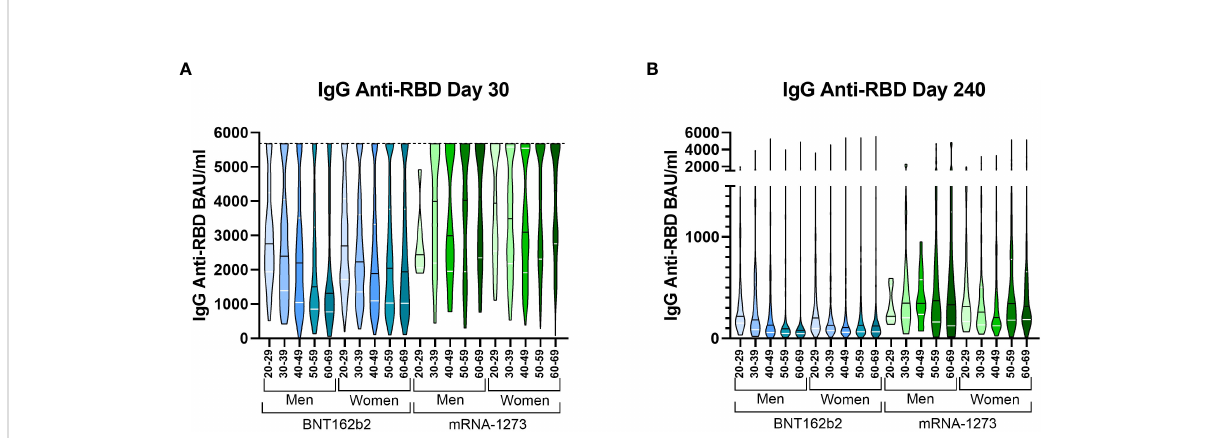
FIGURE 2 IgG anti-RBD levels on day 30 and 240 strati fi ed by all three variables simultaneously. Violin plots representing the IgG anti-RBD levels in BAU/ ml strati fi ed by vaccine type, gender, and age on day 30 (A) and day 240 (B) . The median (black line) and quartiles (white lines) are represented in each violin plot. On day 30, the dotted line at 5,680 BAU/ml indicates the higher limit of quanti fi cation. A Kruskal Wallis test and a Dunn ’ s multiple comparisons test were performed for each variable. IgG anti-RBD levels were calculated in international units